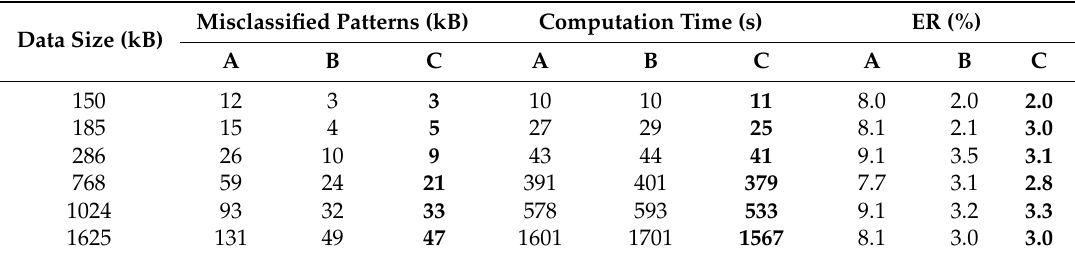
Table 2. Comparisons of misclassified patterns, computation time and the error rate (ER) for different sizes of data sets for railing sensors. A: K-means; B: Fuzzy C-means (FCM); C: AP-DBSCAN.